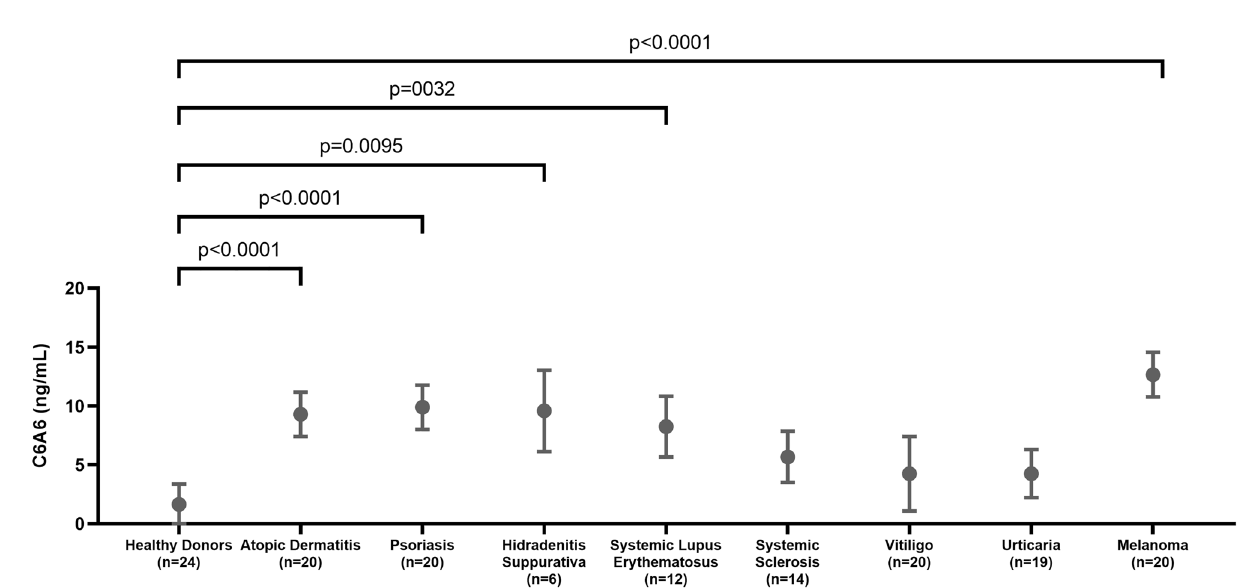
Figure 2. Results from cohort 1. Serum levels of C6A6 were assessed in healthy donors (n = 20), and in patients with atopic dermatitis (n = 20), psoriasis (n = 20), hidradenitis suppurativa (n = 6), systemic lupus erythematosus (n = 12), systemic sclerosis (n = 14), urticaria (n = 19), vitiligo (n = 20), and melanoma (n = 20). Mean with 95% confidence interval. Data was analyzed using an ANCOVA corrected for age and gender. Data are depicted as mean ±